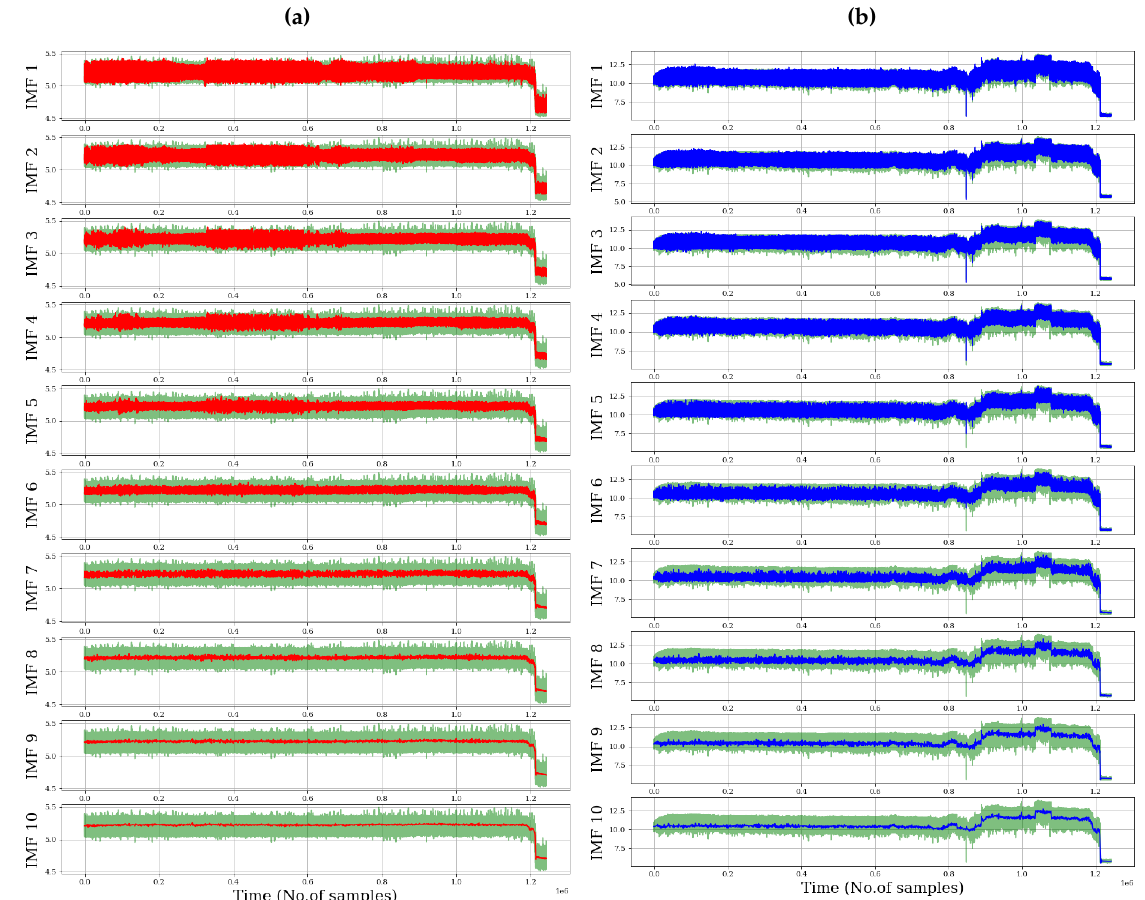
Figure 6. Extracted IMFs from the pressure signals from the whole run-to-failure test ( a ) Suction, ( b ) Delivery.